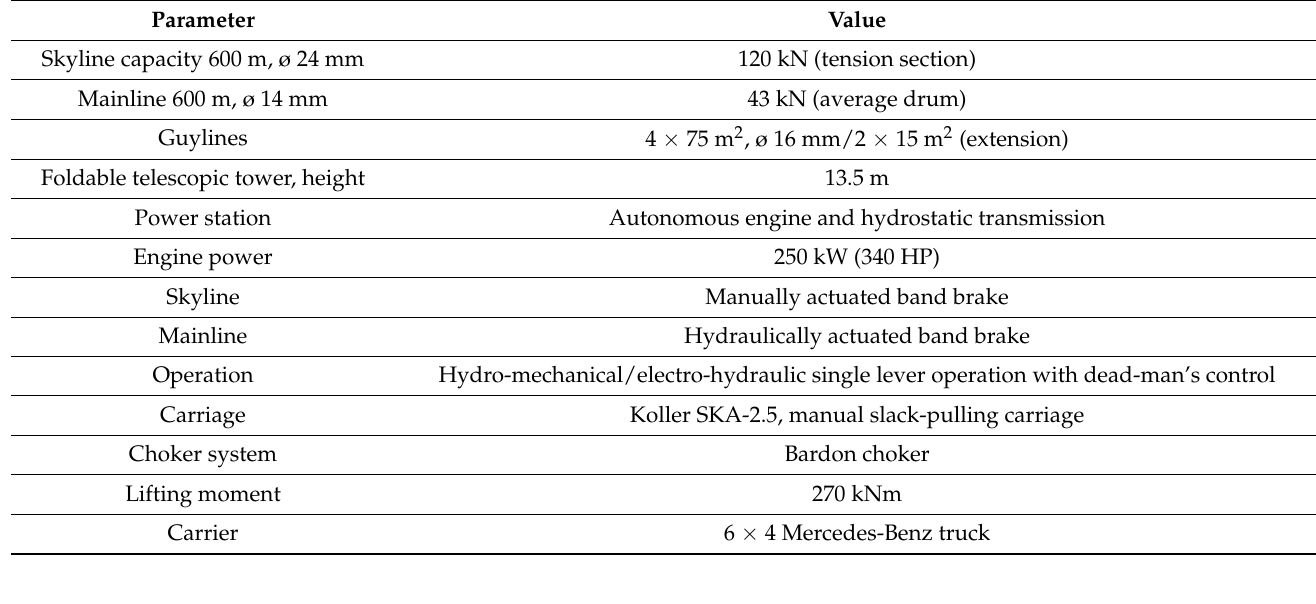
Table 2. Technical characteristics of the cable crane.